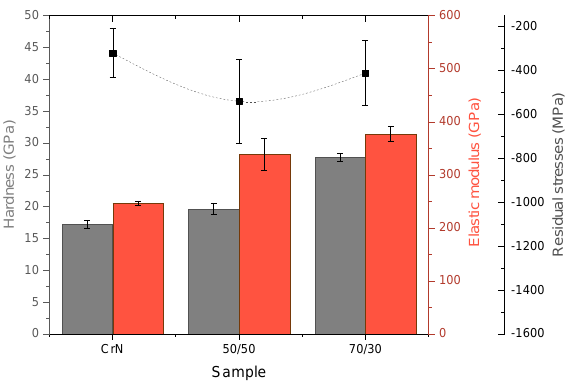
Figure 8. Hardness, elastic modulus, and residual stress as a function of the Al/Cr ratio.